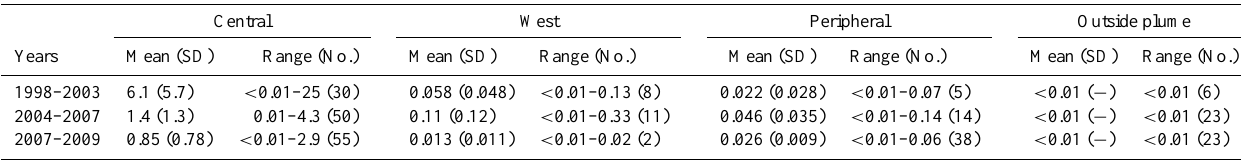
Table 2. Concentrations of BAM for the four zones (Fig. 5) and three time intervals. For each zone and time interval, the mean, standard deviation (SD), range and number of samples are reported. When the concentration was less than the detection limit (0.01µgl − 1 ) 0.005µgl − 1 was used in the calculation of the mean and standard deviation.